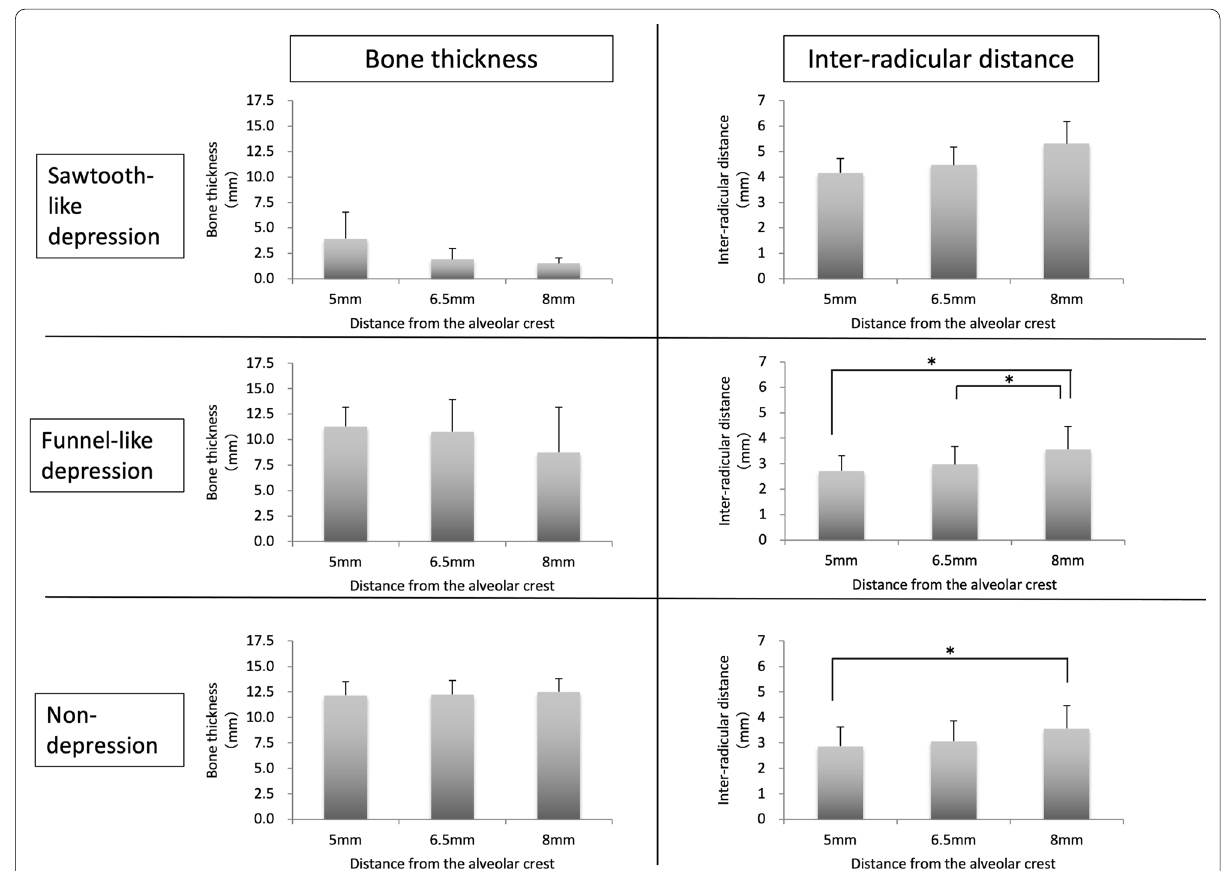
Fig. 5 Comparison of buccolingual bone thickness and inter-radicular distance by distance from the alveolar crest in each sinus morphology